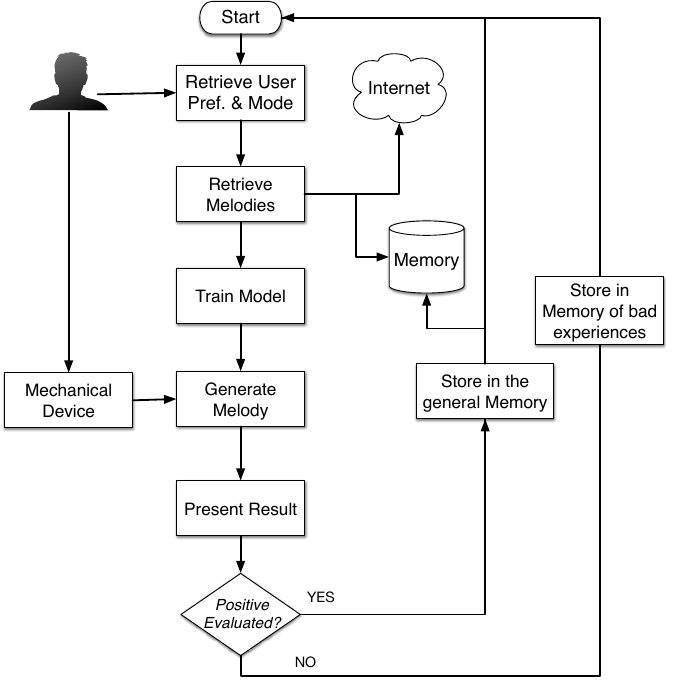
Figure 1. Illustration of the flow followed by the whole